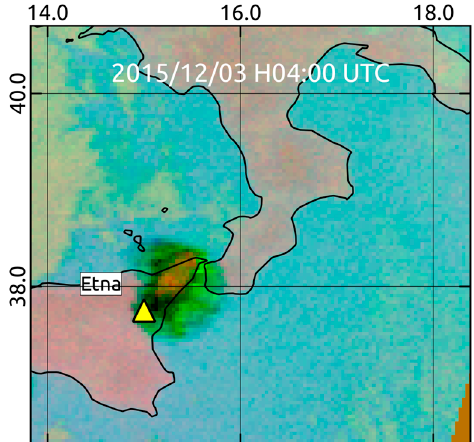
Figure 9. Ash RGB product from SEVIRI data of 3 December at 04:00 UTC generated according to the EUMETSAT scheme. Green pixels indicated SO 2 areas, orange/brown pixels and dark ‐ blue pixels respectively marked a thick and thin ice cloud.